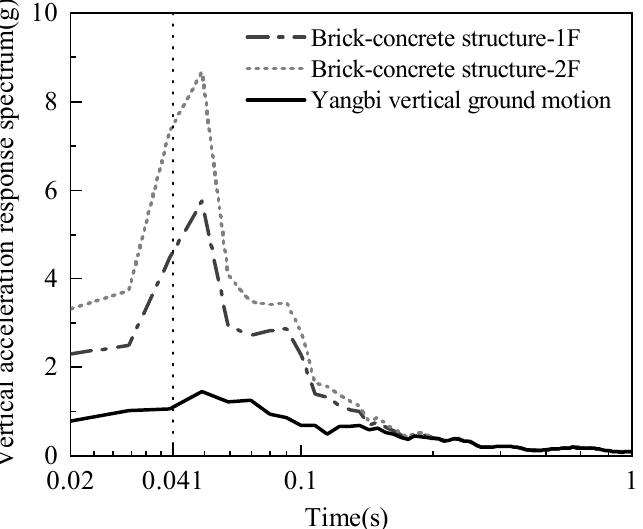
Figure 10. The vertical acceleration response spectrum of the Yangbi vertical ground motion and the floors of the structure.